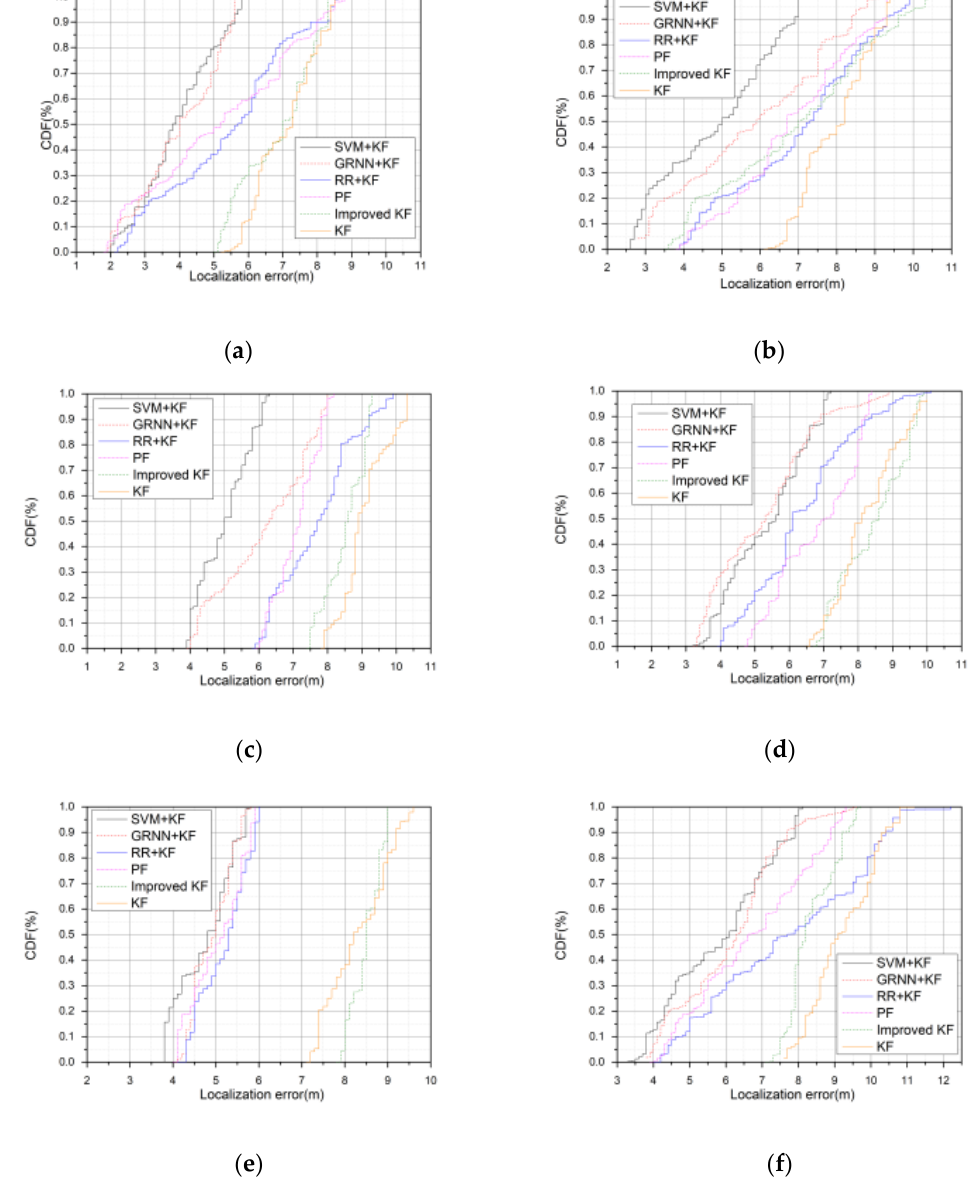
Figure 8. Comparison of Cumulative Distribution Function (CDF) localization error between different